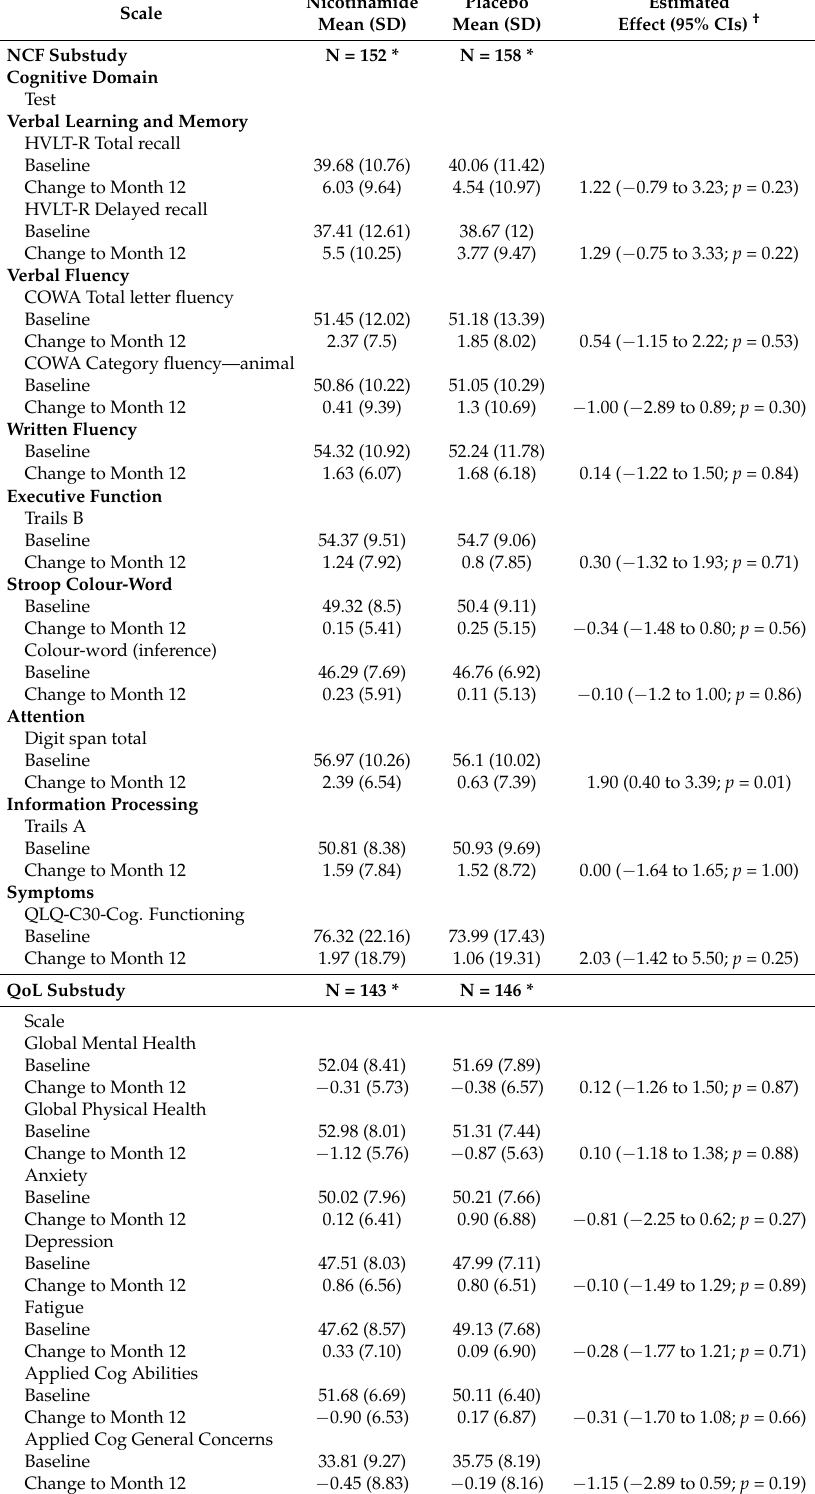
Table 2. NCF and QoL Substudy